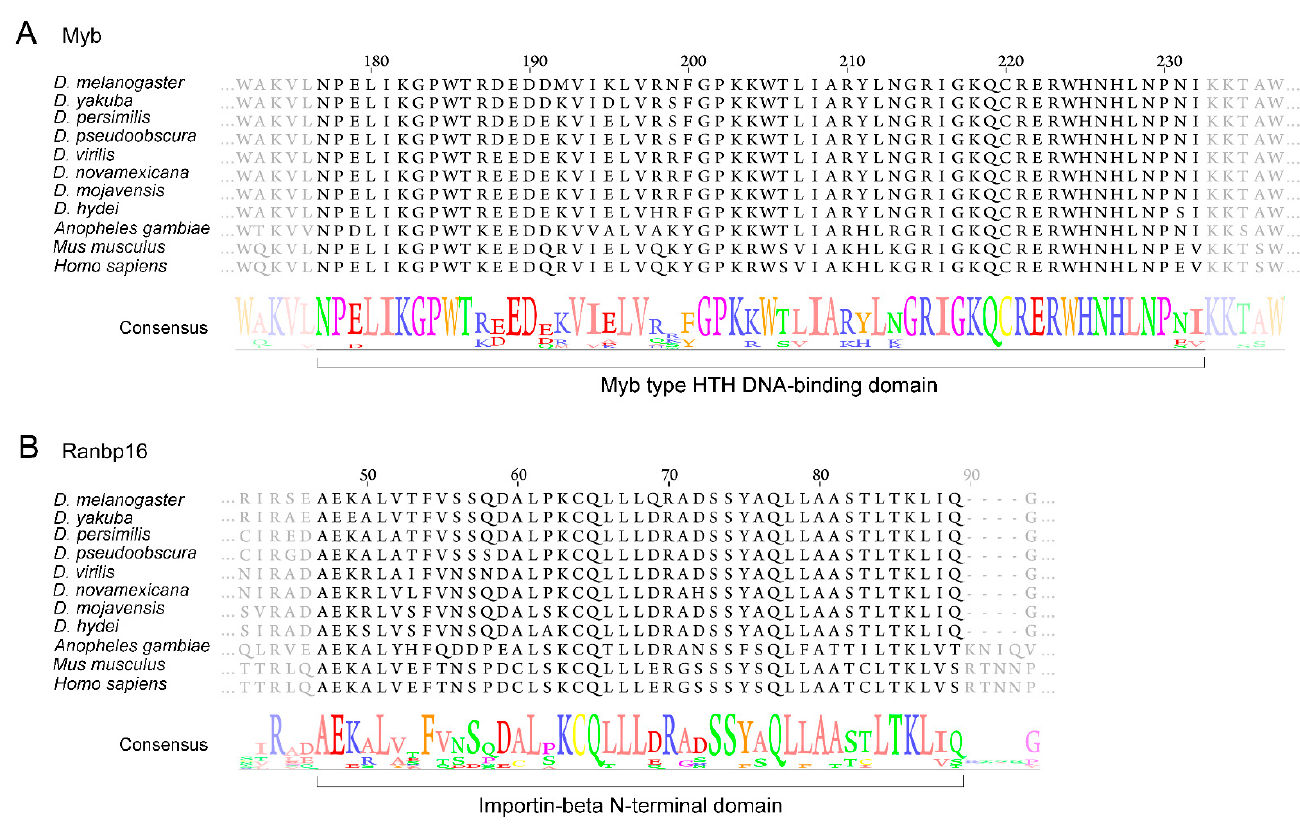
Figure 2. Multiple protein alignment of Myb type Helix-Turn-Helix (HTH) DNA-binding domain of Myb protein ( A ) and Importin- β domain of Ranbp16 protein ( B ) across selected taxa.